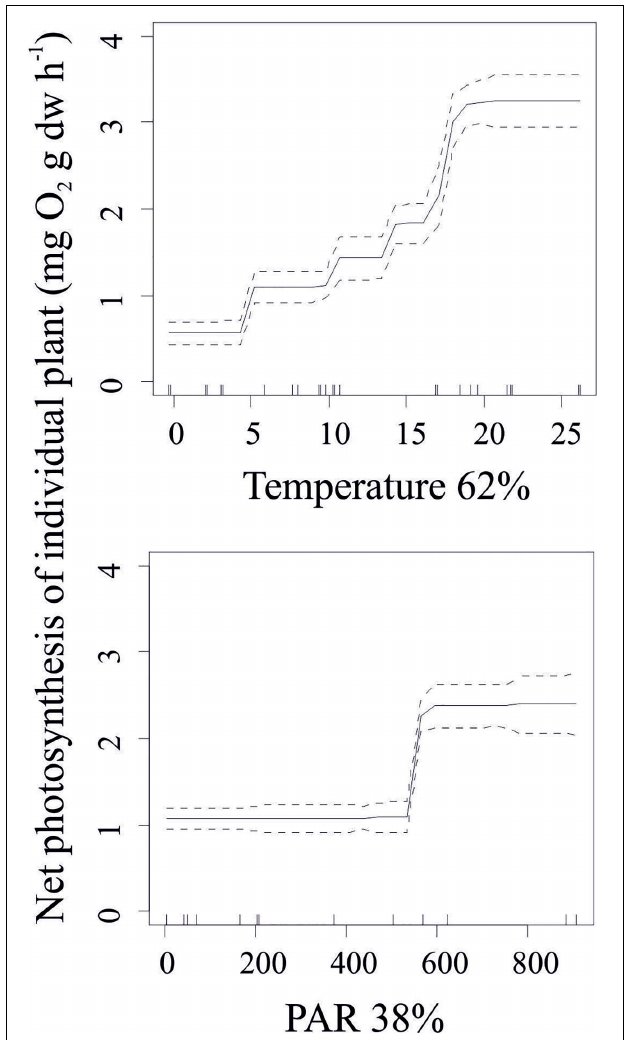
FIGURE 4 | Standardized functional-form relationships ( ± Standard Error) showing the effect of environmental variables on the net photosynthesis of individual plants of C. aspera , whilst all other variables are held at their means. The variables are ordered by their relative contribution in the BRT model (shown in%). Upward tickmarks on x -axis show the frequency distribution of data along this axis. See the section of methods for further information on environmental variables.